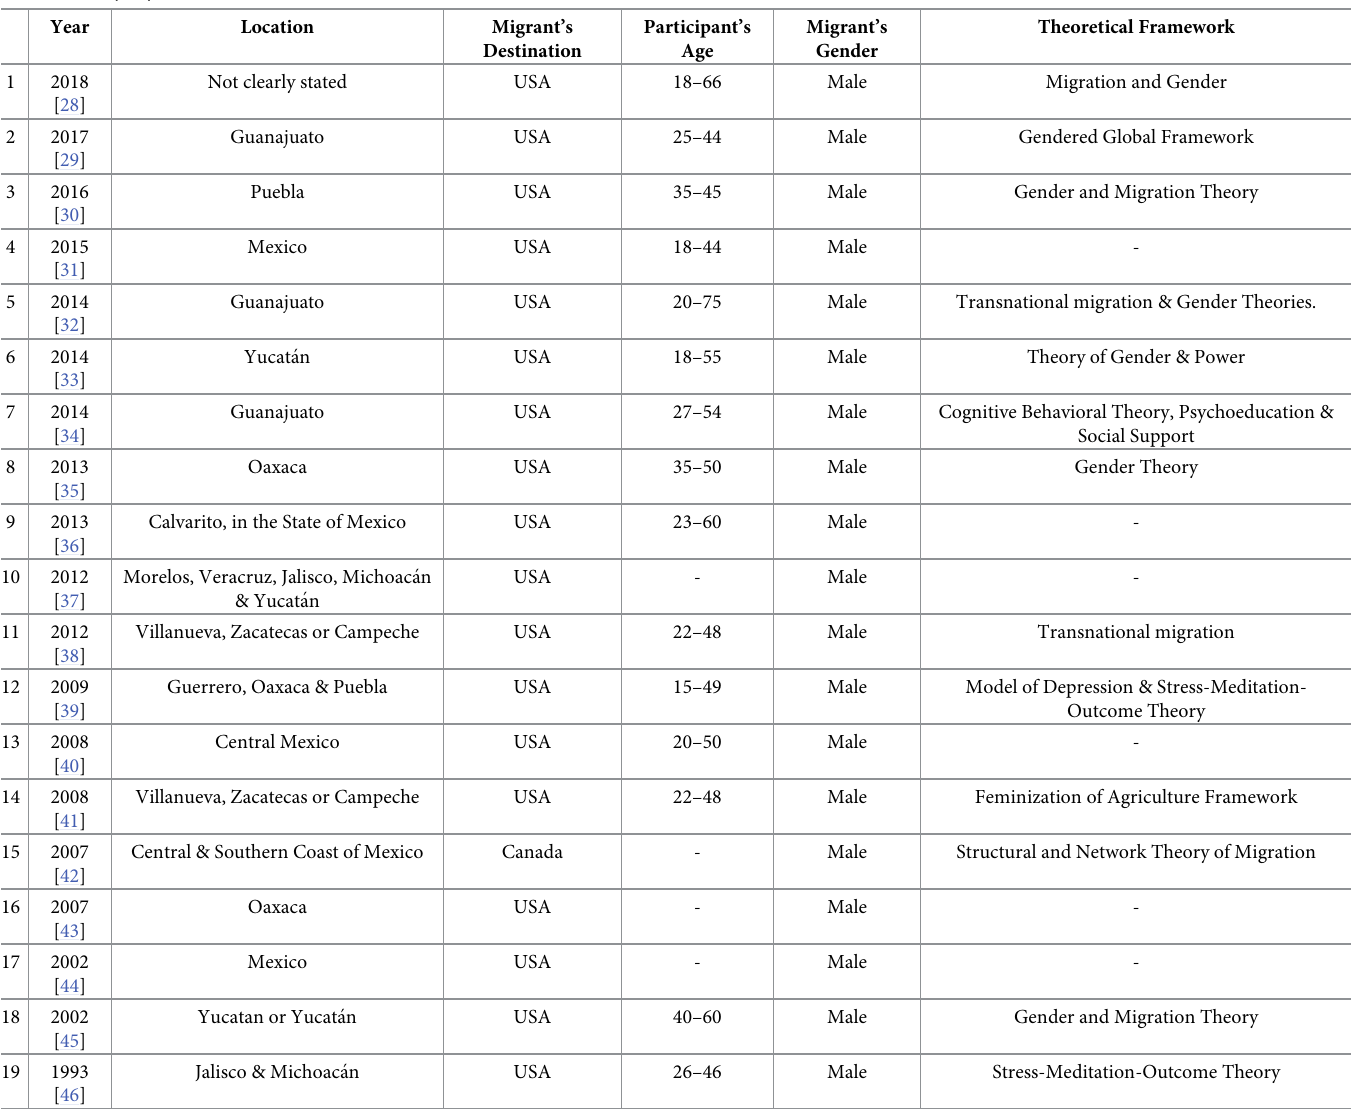
Table 3. Study key characteristics. Edmonton, AB, Canada,